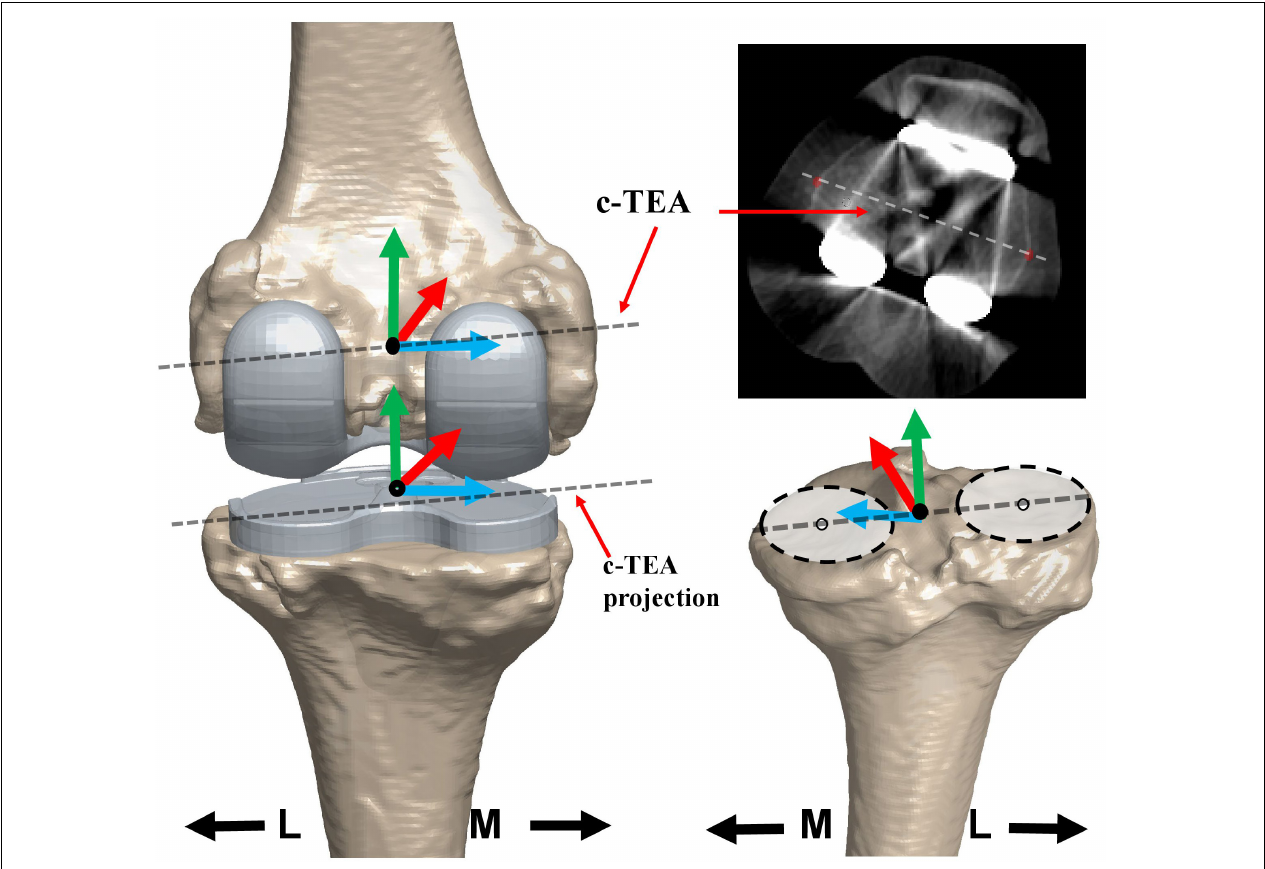
FIGURE 2 | The local coordinate system of the femur and the tibia. The coordinate systems of the femur and tibia are based on the 3D knee model of MP TKA patients reconstructed from computer tomography (CT) images. The dotted line on the 3D model and in the CT image of the femoral prostheses was the clinical trans-epicondylar axis (TEA) of the femur. The dotted line on the tibial prosthesis was the projection of the clinical trans-epicondylar axis (TEA). The dotted line on the non-operated tibial plateau was the line connecting the two best-fitted circles. The black solid point indicated the center of the femur or tibia. The red, green, and blue lines showed the anterior/posterior (AP), proximal/distal (PD), and medial/lateral (ML) axes,